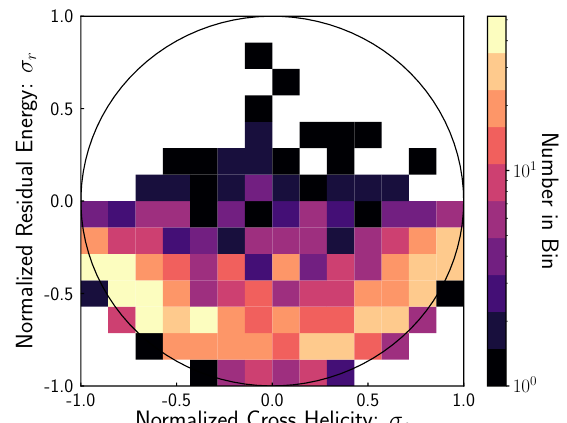
Figure 1. Two-dimensional histogram of the samples conditioned on the normalized cross helicity and normalized residual energy.